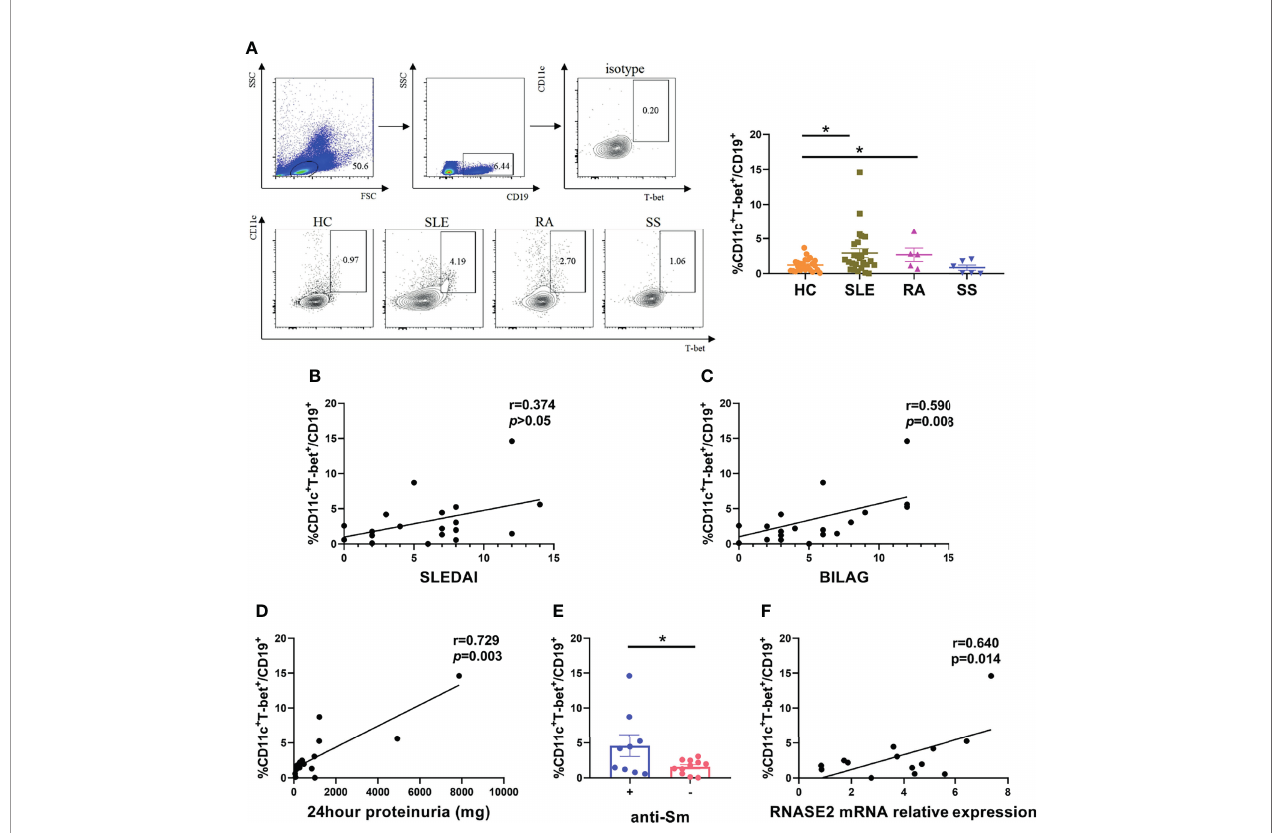
FIGURE 2 | Association of age-associated B cells subset (ABCs) with RNASE2 expression in SLE patients. (A) PBMCs from 24 HC, 26 SLE, 5 RA and 6 SS patients was collected and analyzed for the proportion of CD11c + T-bet + cells in CD19 + B cells by fl ow cytometry. (B, C) The percentage of CD11c + T-bet + B cells was related to SLE disease activity score (SLEDAI and BILAG) (by Spearman correlation test). (D) The percentage of CD11c + T-bet + B cells was associated with the amount of 24hour proteinuria (by Spearman correlation test). (E) The proportion of CD11c + T-bet + B cells was increased in SLE patients with positive anti-Sm antibody. (F) The proportion of CD11c + T-bet + B cells was closely related to RNASE2 mRNA levels in SLE patients (n=14). Data are presented as mean ± SEM, *p <